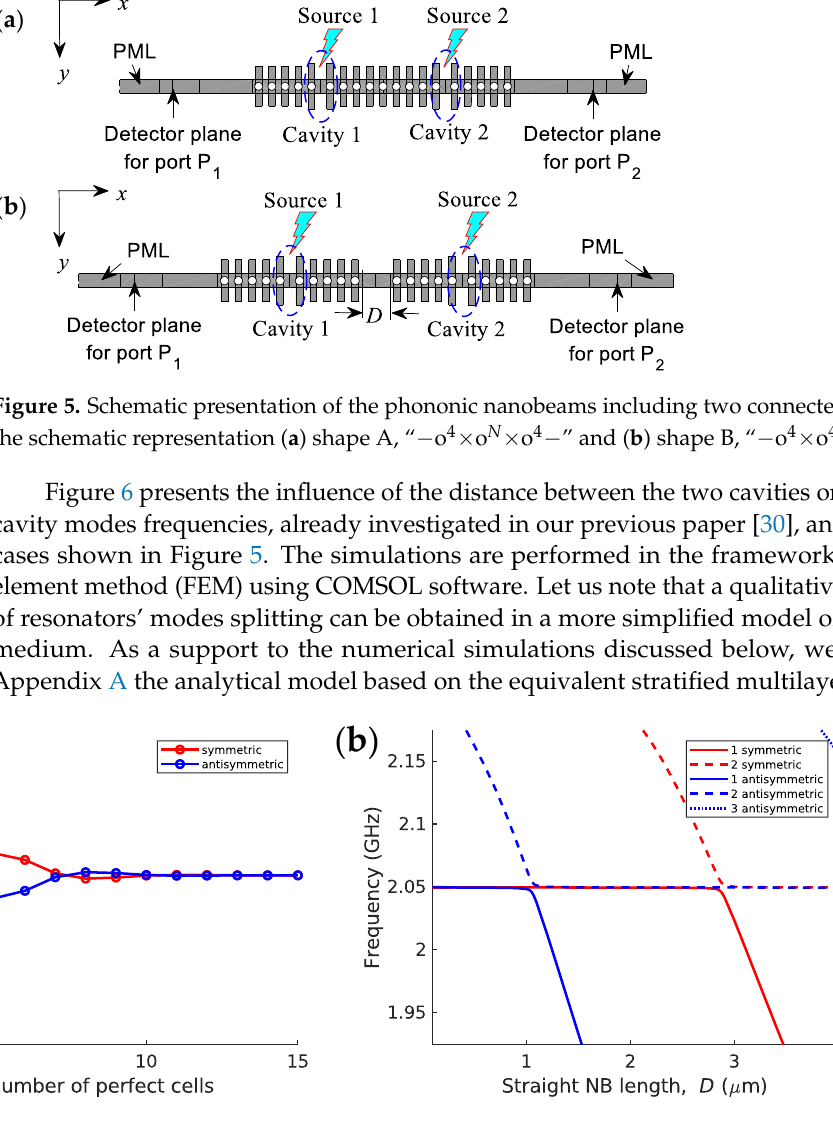
Figure 6. ( a ) Evolution of the resonant frequency as a function of the number of perfect unit cells separating the two cavities (Figure 5a). ( b ) same as ( a ) as a function of length D of the straight waveguide connecting the two phononic crystals containing the cavities (Figure 5b). The assignments (1, 2, 3) in the legend of panel ( b ) represent the symmetries of the modes.